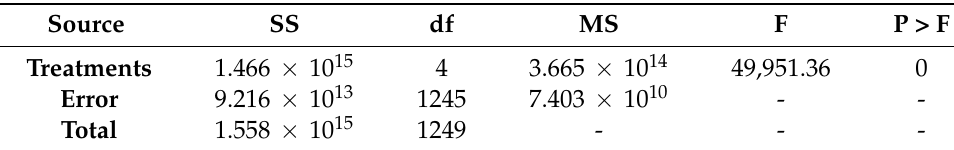
Table 3. Anova Table.